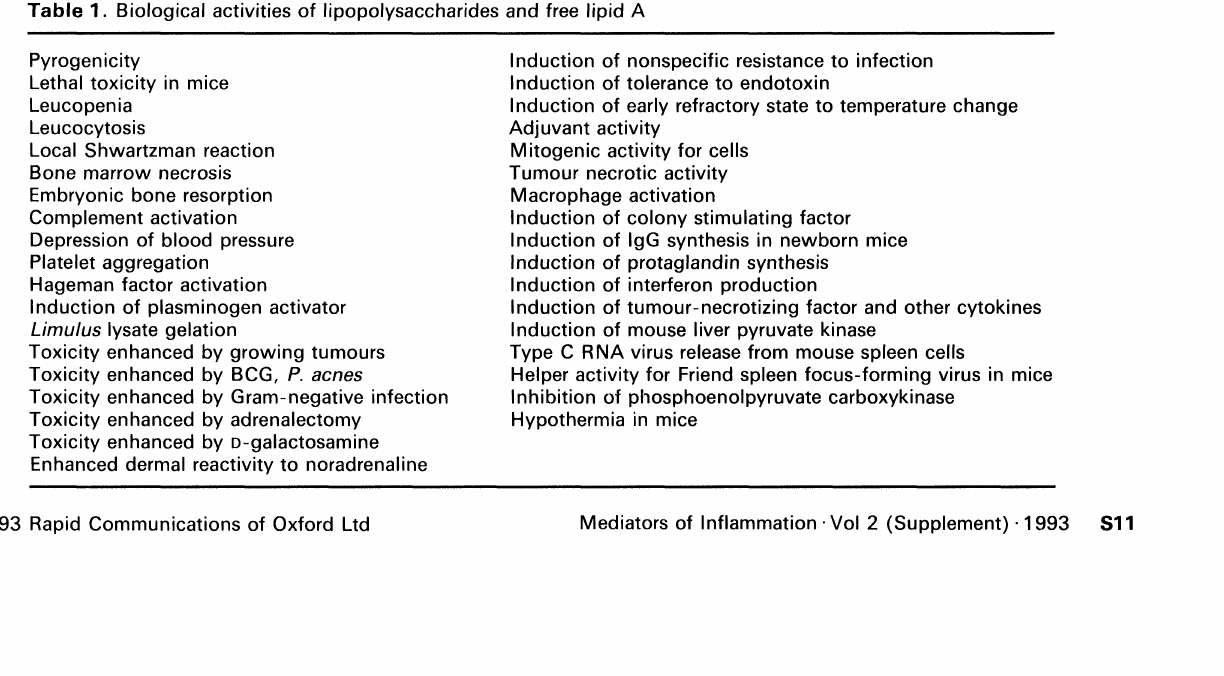
Table 1. Biological activities of lipopolysaccharides and free lipid